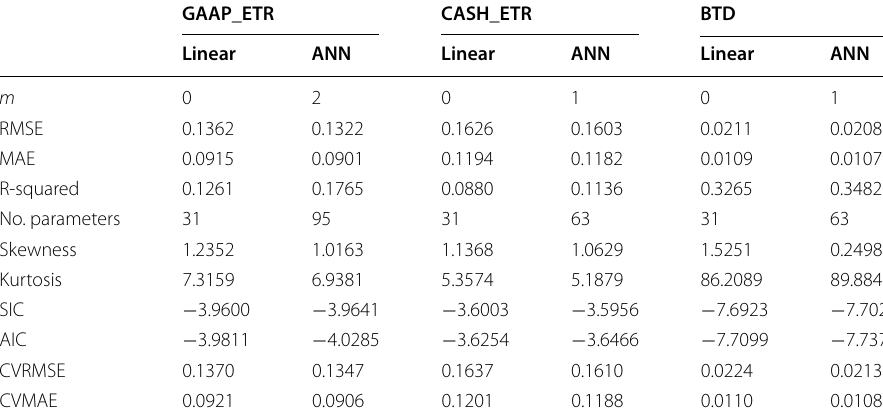
Table 5 Goodness‑of‑fit and cross‑validated statistics for linear and ANN models